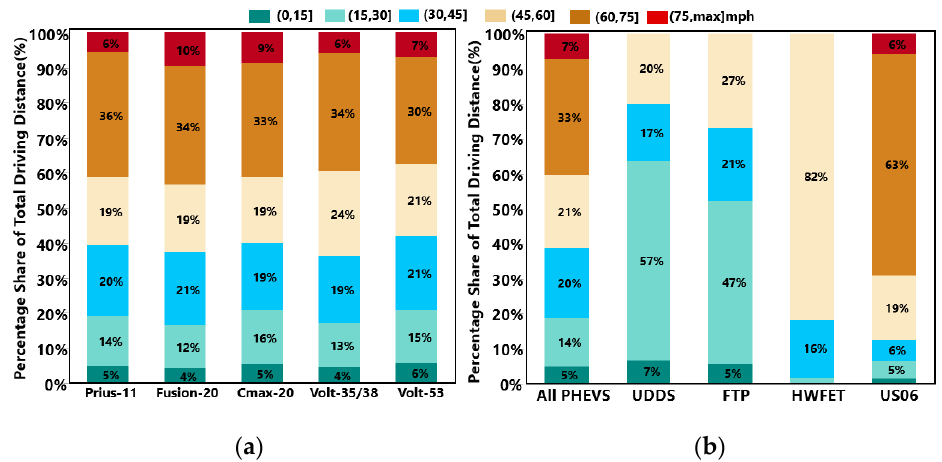
Figure 5. Percentage share of total driving distance by driving speed in mph: ( a ) Observed PHEVs; ( b ) Comparison with EPA Test Cycles.